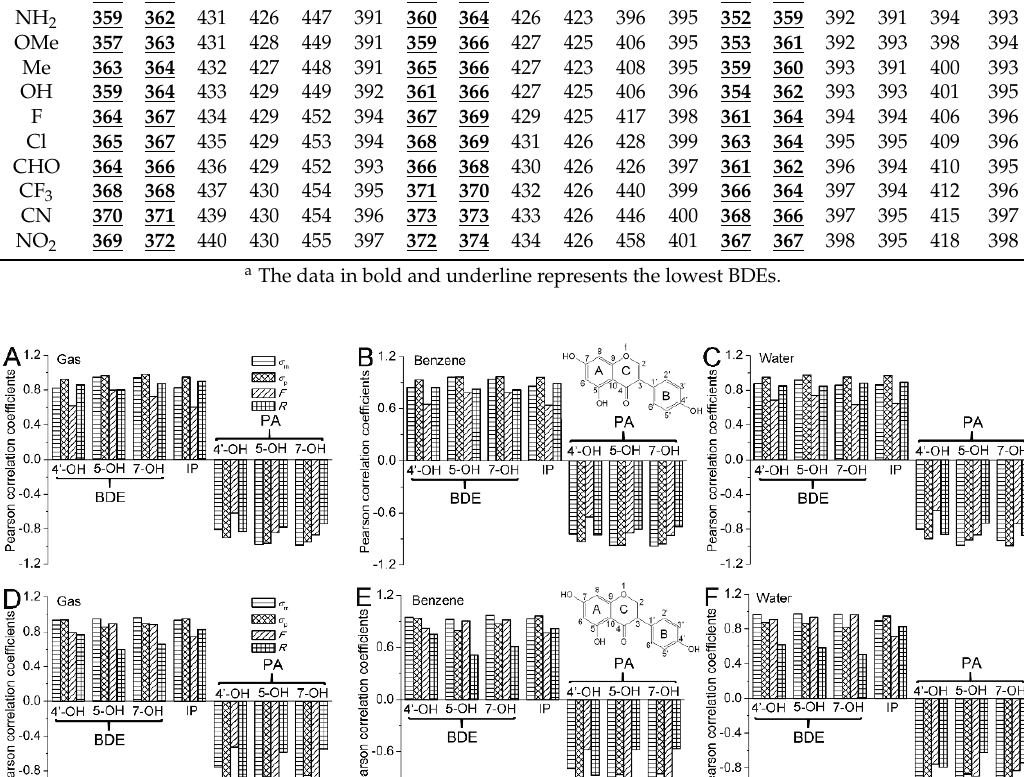
Figure 3. Dependence of BDE on Hammett sigma constants for 4′,5,7 -trihydroxyisoflavone ( A ) and 4,5,7-trihydroxyisoflavanone ( B ) in gas, benzene, and water phases. The Pearson correlation between the F / R and the BDEs are also done and corresponding correlation coefficients are drawn as histograms in Figure 2. In Figure 2, it can also be observed that the correlation between the BDE of isoflavone and R is much better than that between the BDE of